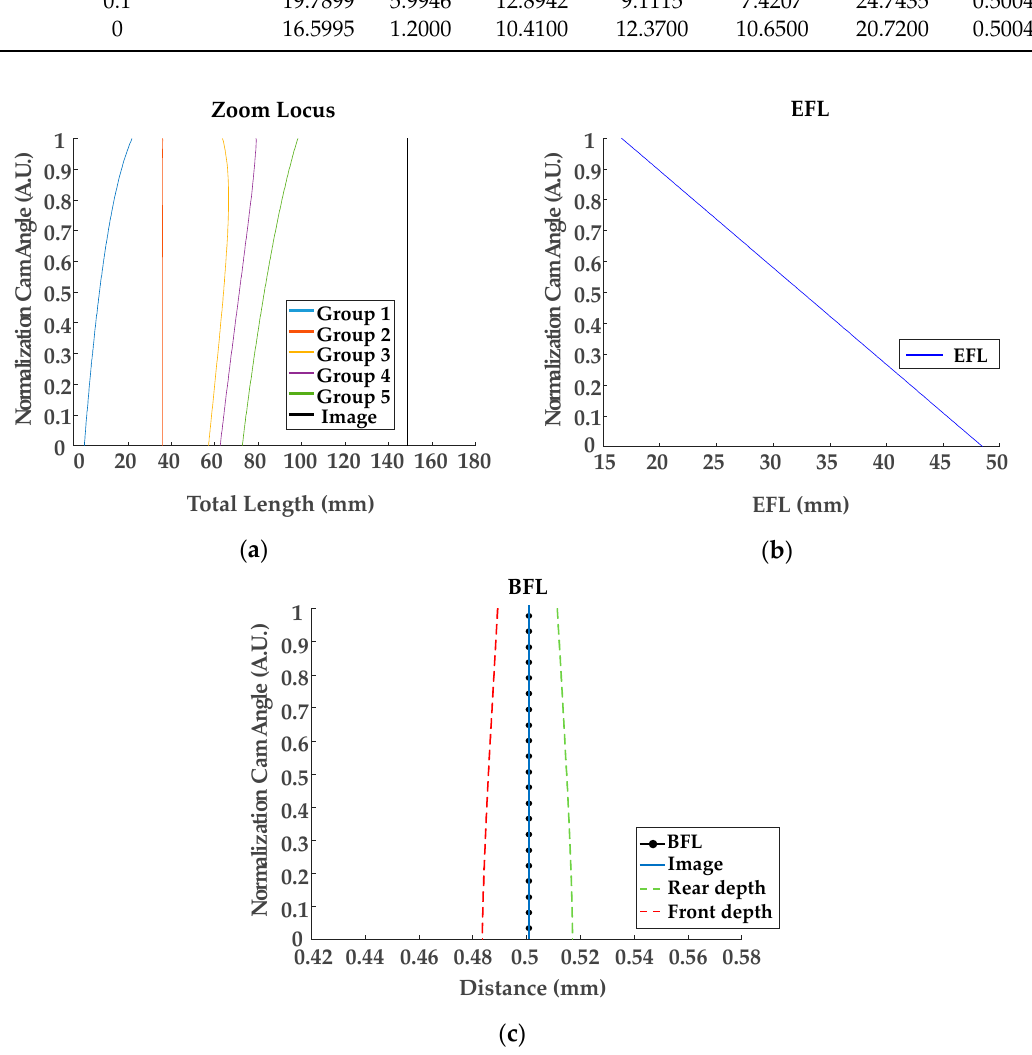
Figure 8. Result of correcting error for image plane and EFL by moving first and fourth lens groups, as shown in Table 6. ( a ) Zoom locus of each lens group, ( b ) EFL of this optical system, and ( c ) error for image plane.